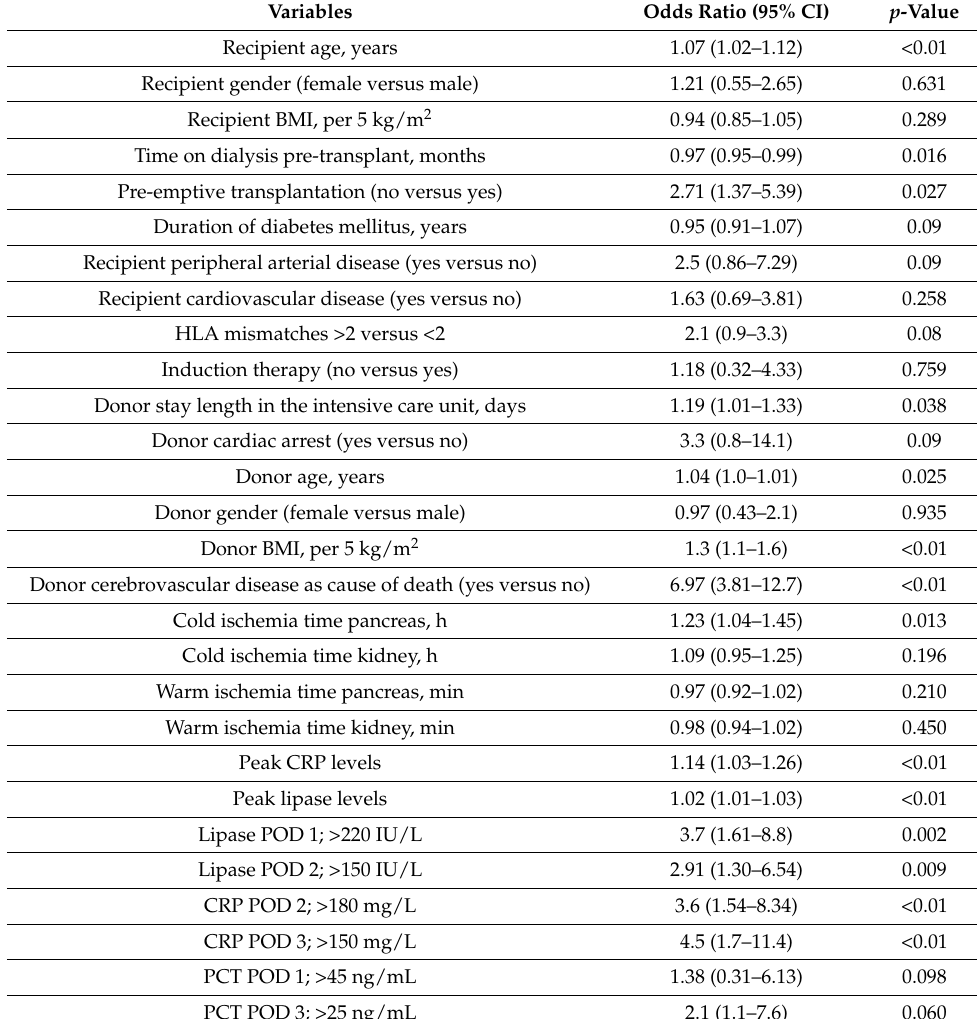
Table 6. Univariate logistic regression analysis of factors correlated to the occurrence of early pancreatic graft dysfunction following